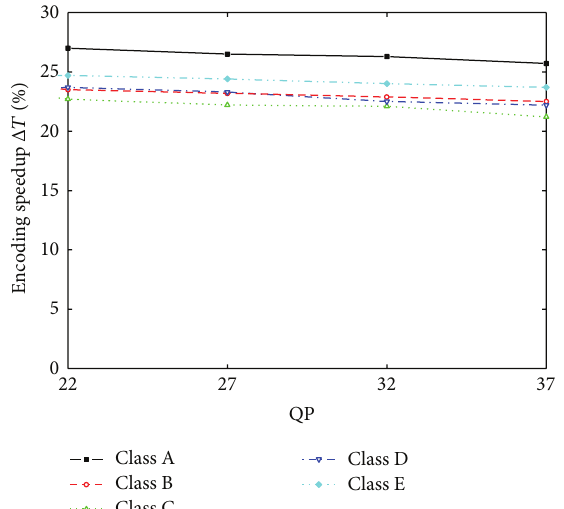
Figure 7: Encoding speedup curves of each sequence class for HCR versus